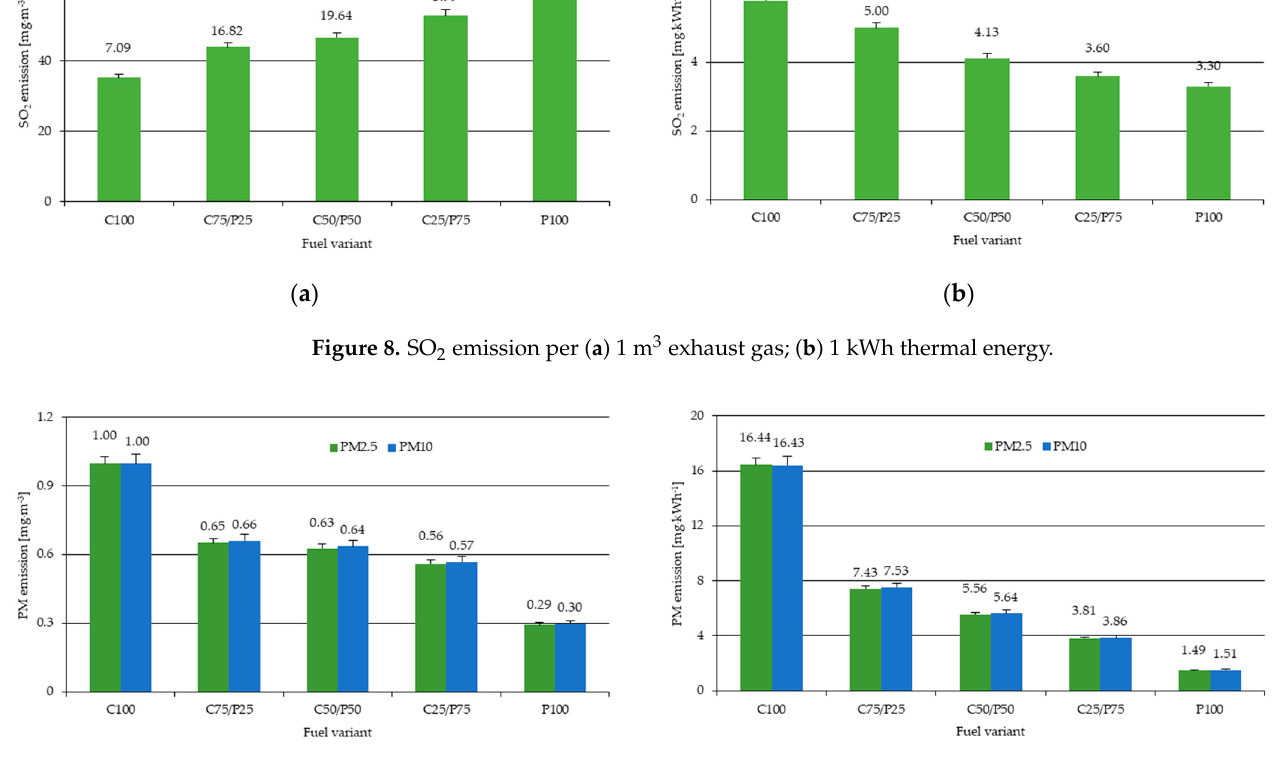
Figure 8. SO 2 emission per ( a ) 1 m 3 exhaust gas; ( b ) 1 kWh thermal energy.